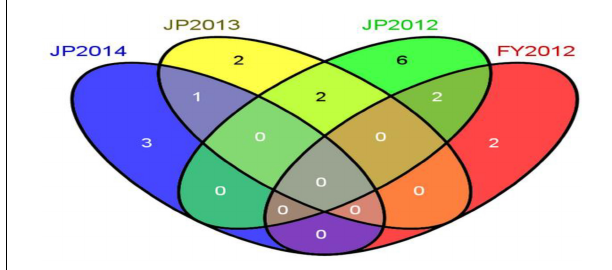
FIGURE 3 | QTLs identified in different individual environments (FY2012, JP2012, JP2013, and JP2014).